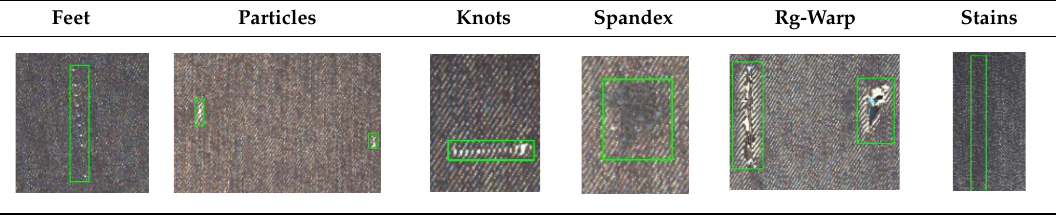
Table 1. Samples of di ff erent classes of Fabric Defects (FBDF).